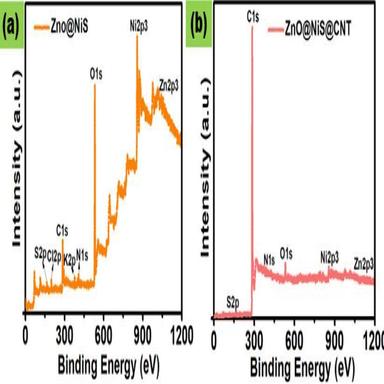
XPS survey spectrum of ZnO/NiS and ZnO/NiS/CNT electrodes on a nickel foam substrate.